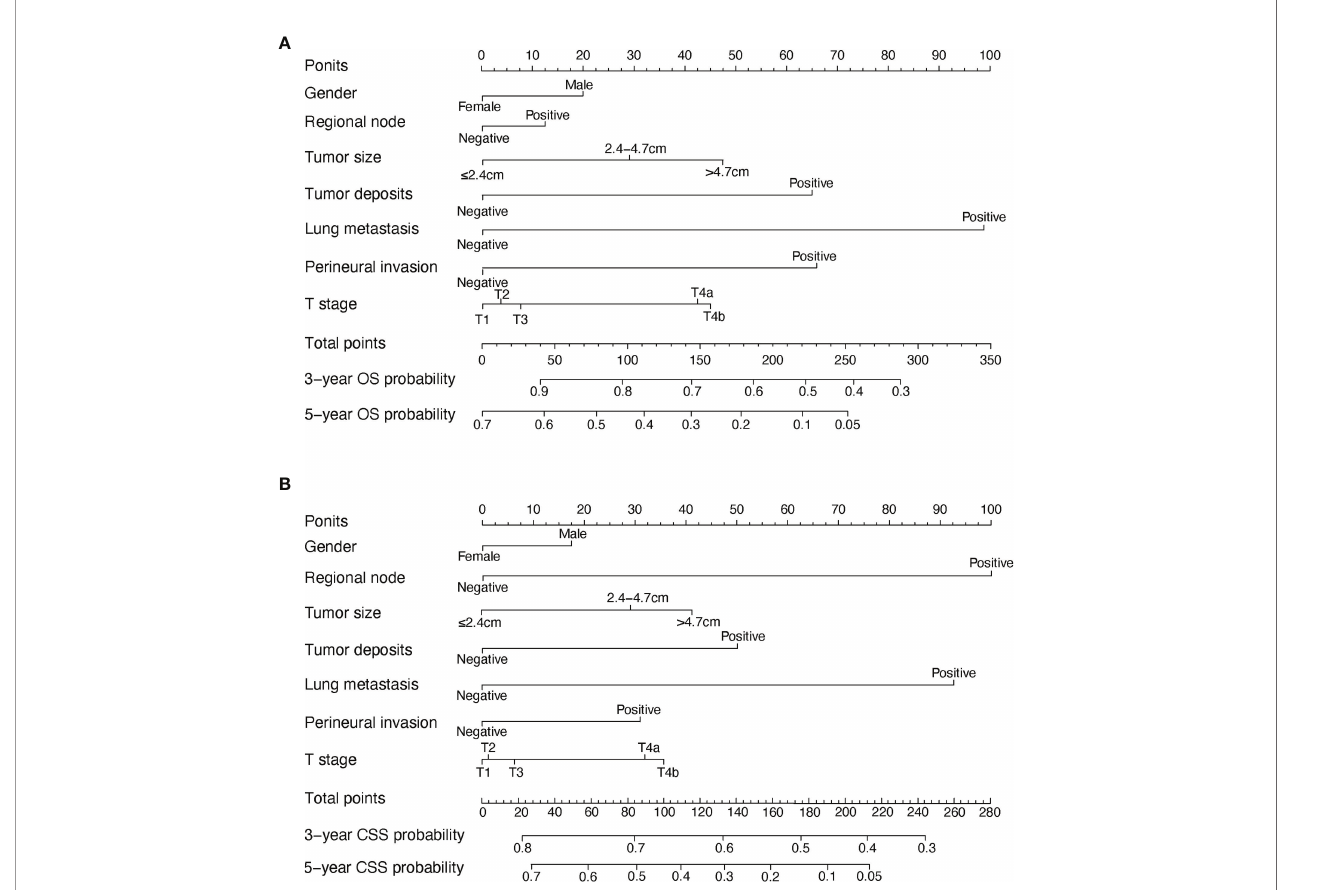
FIGURE 2 | OS and CSS associated nomograms for EOCA patients. (A) OS nomograms for EOCA in 3- and 5-year; (B) CSS nomograms for EOCA in 3- and 5- year. OS, overall survival; CSS, cancer-speci fi c survival; EOCA, early onset colon